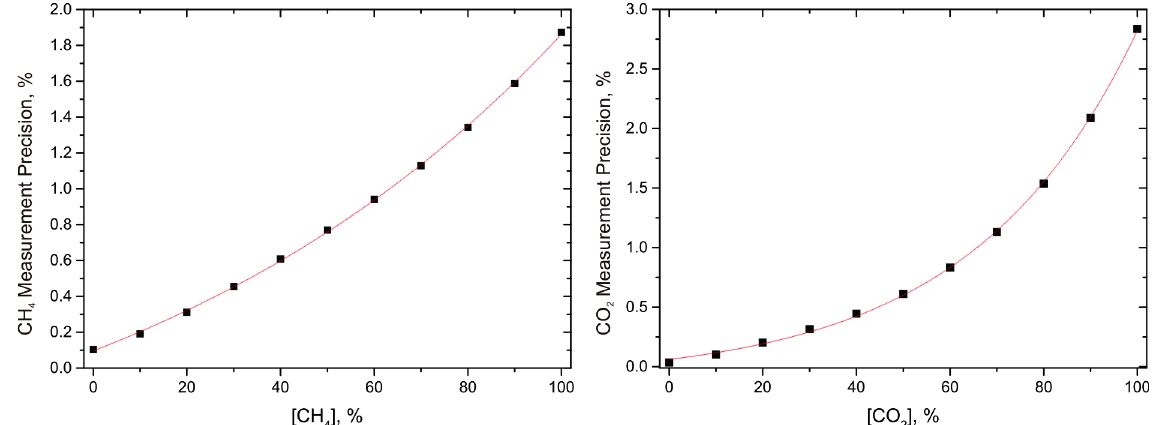
Figure 6. Measurement precision of both sensors, in dependence of the target gas concentration. The dots represent the measurement precision calculated from the measured data; the red lines show an exponential fit for